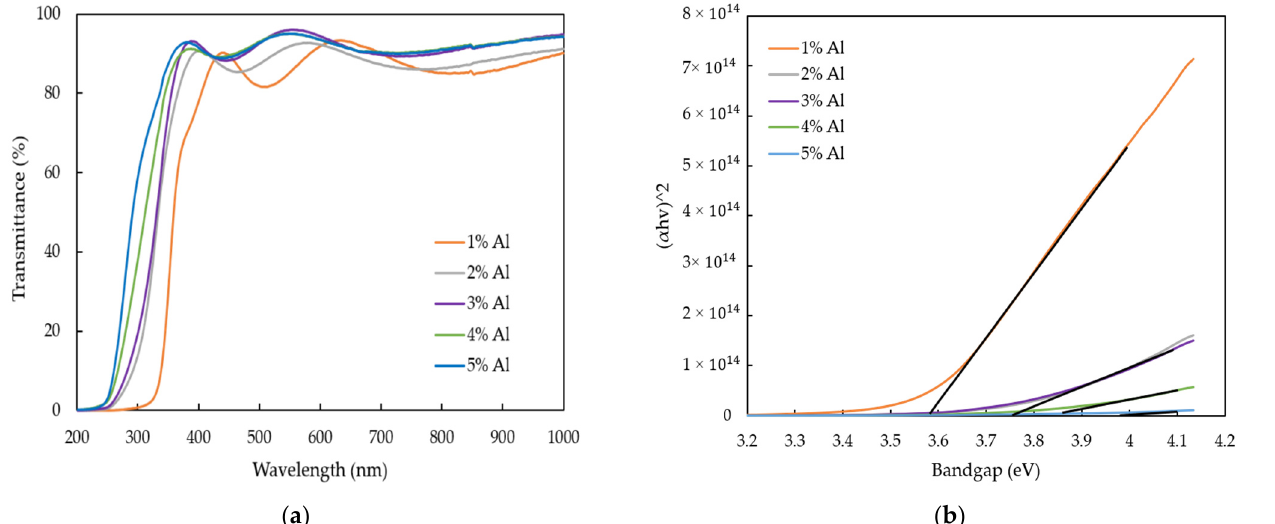
Figure 6. ( a ) Optical transmittance spectra, and ( b ) Variation of bandgap in AZO films deposited with different Al ratios by the mist CVD method.